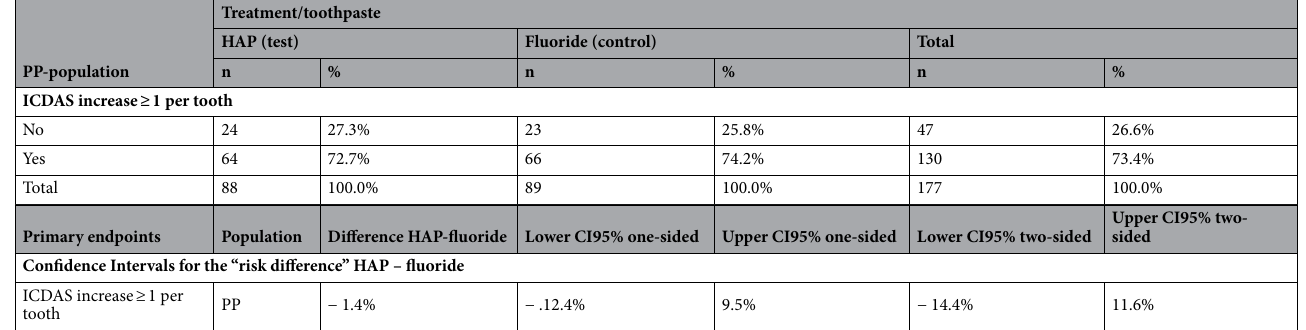
Table 2. Development of enamel caries lesions with ICDAS code ≥ 1 or the progression of an existing enamel caries lesion by at least one ICDAS code in the PP-population and confidence intervals for the “risk difference”. CI95%, confidence interval; PP, per protocol; HAP,